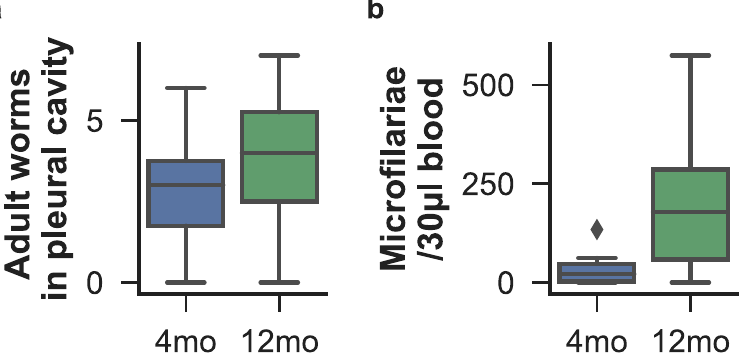
Figure 1. Susceptibility to helminth infection increased with age. Parasite survival and fecundity were measured in 4 and 12-month-old (respectively 4mo and 12mo) mice that were subcutaneously infected 2 months prior with 40 L . sigmodontis infective larvae to investigate the effects of host age on susceptibility to chronic helminth infection. ( a ) While no significant difference was observed in adult parasite survival between the different age classes, ( b ) greater densities of microfilariae were detected in the peripheral blood of 12mo than of 4mo mice (P Mann-Whitney = 0.038, n = 8 per group). Worm counts are summarised as boxplots where horizontal lines represent the group median, boxes the inter-quartile range, whiskers the overall range, and diamonds represent outliers ( <± 1.5 × the interquartile